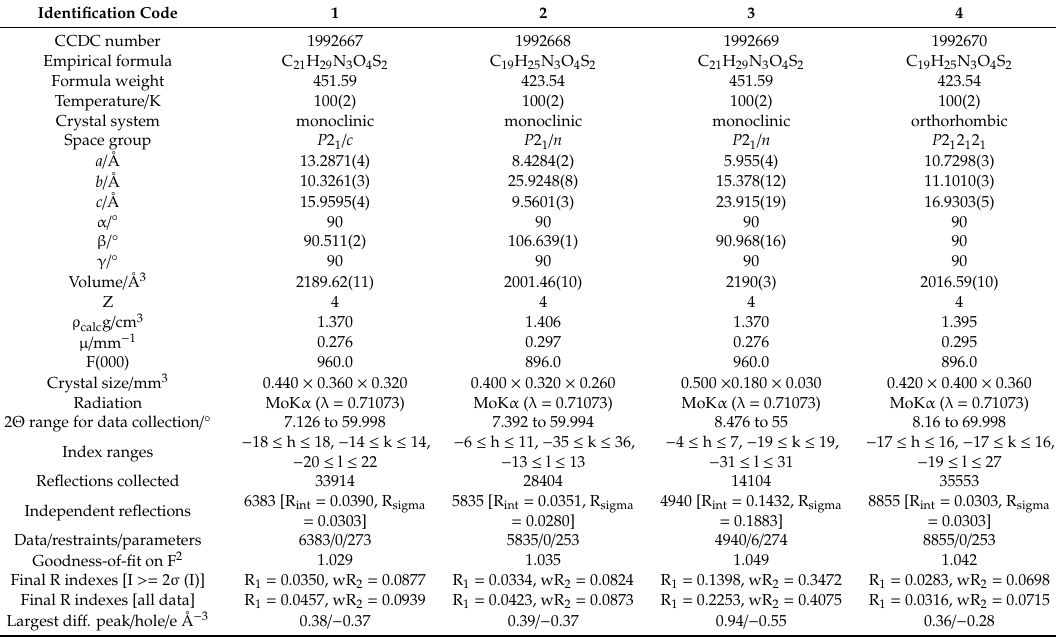
Table 1. Crystal data and structure refinement for 1 – 4